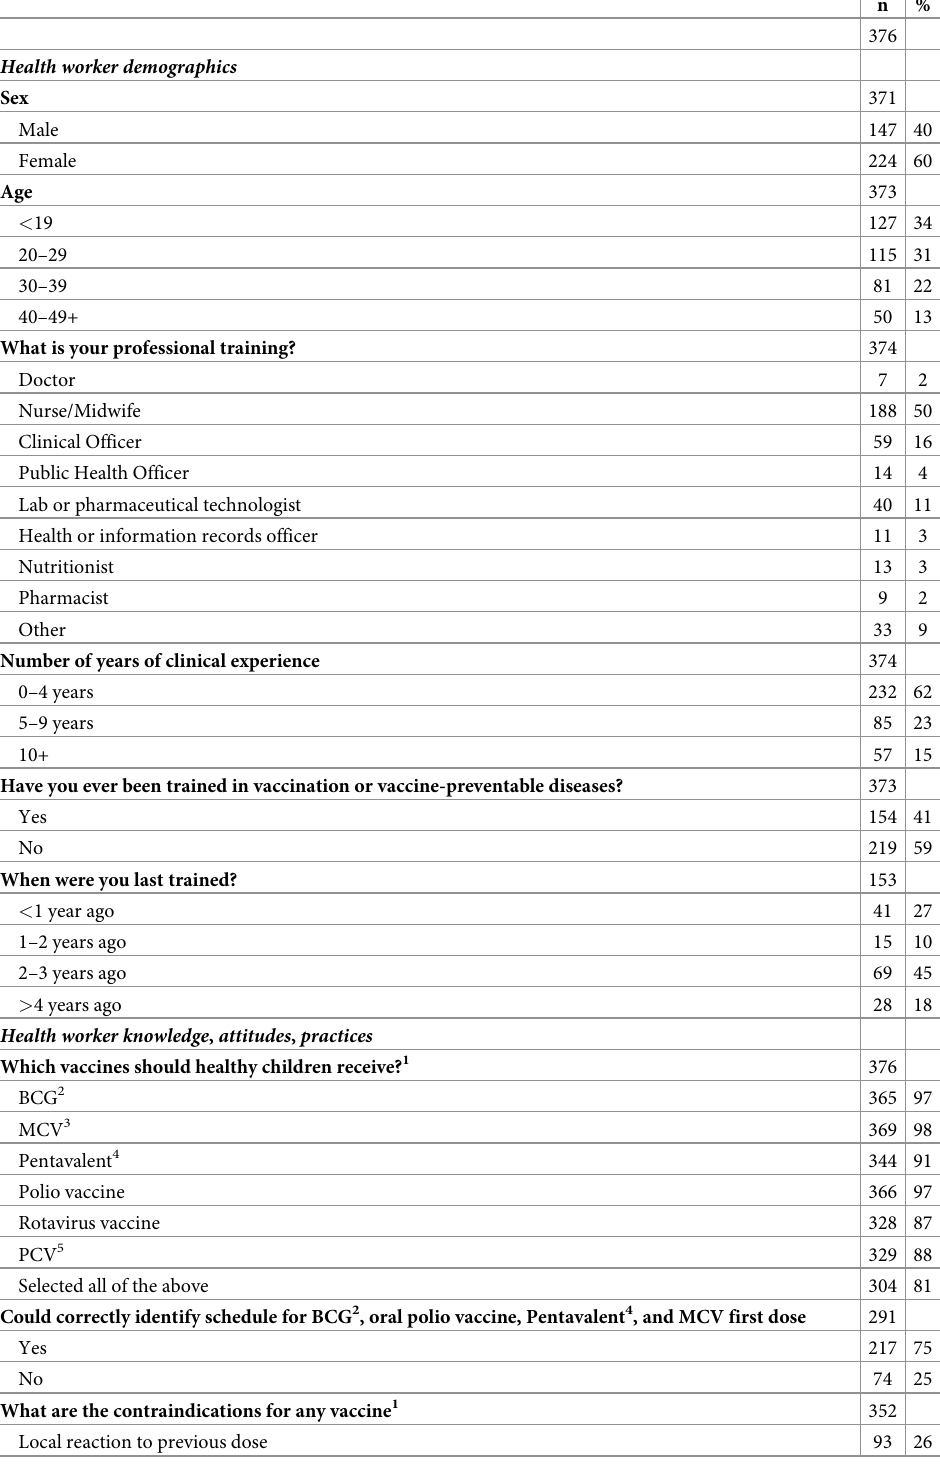
Table 5. Characteristics and knowledge, attitudes, and practices of surveyed health workers, missed opportunities for vaccination (MOV) assessment, Kenya, 2016.